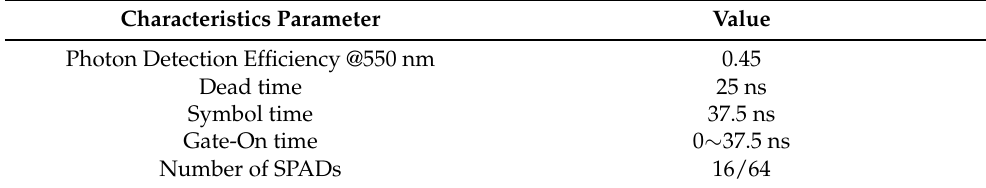
Table 1. SPAD system parameter